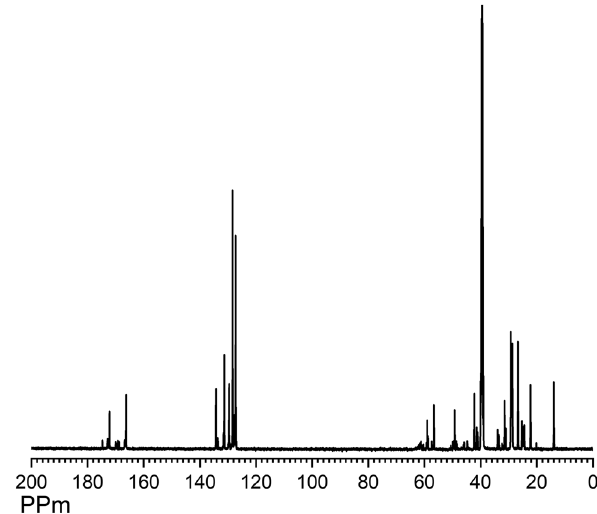
Figure 3: 13 C NMR spectra of ROHA.